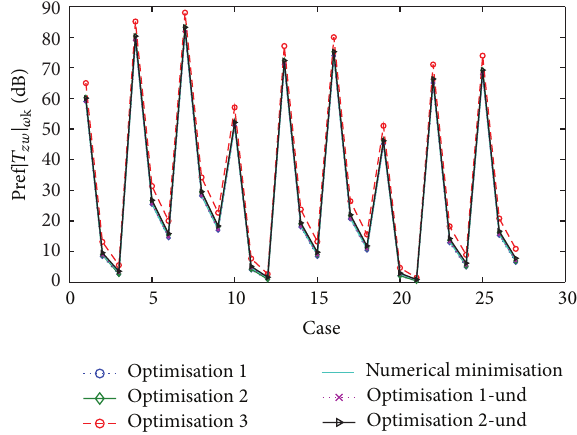
Figure 15: Perf |𝑇 𝑧𝑤 | 𝜔 for all the methods considered and for all the 𝑘 cases listed in Table